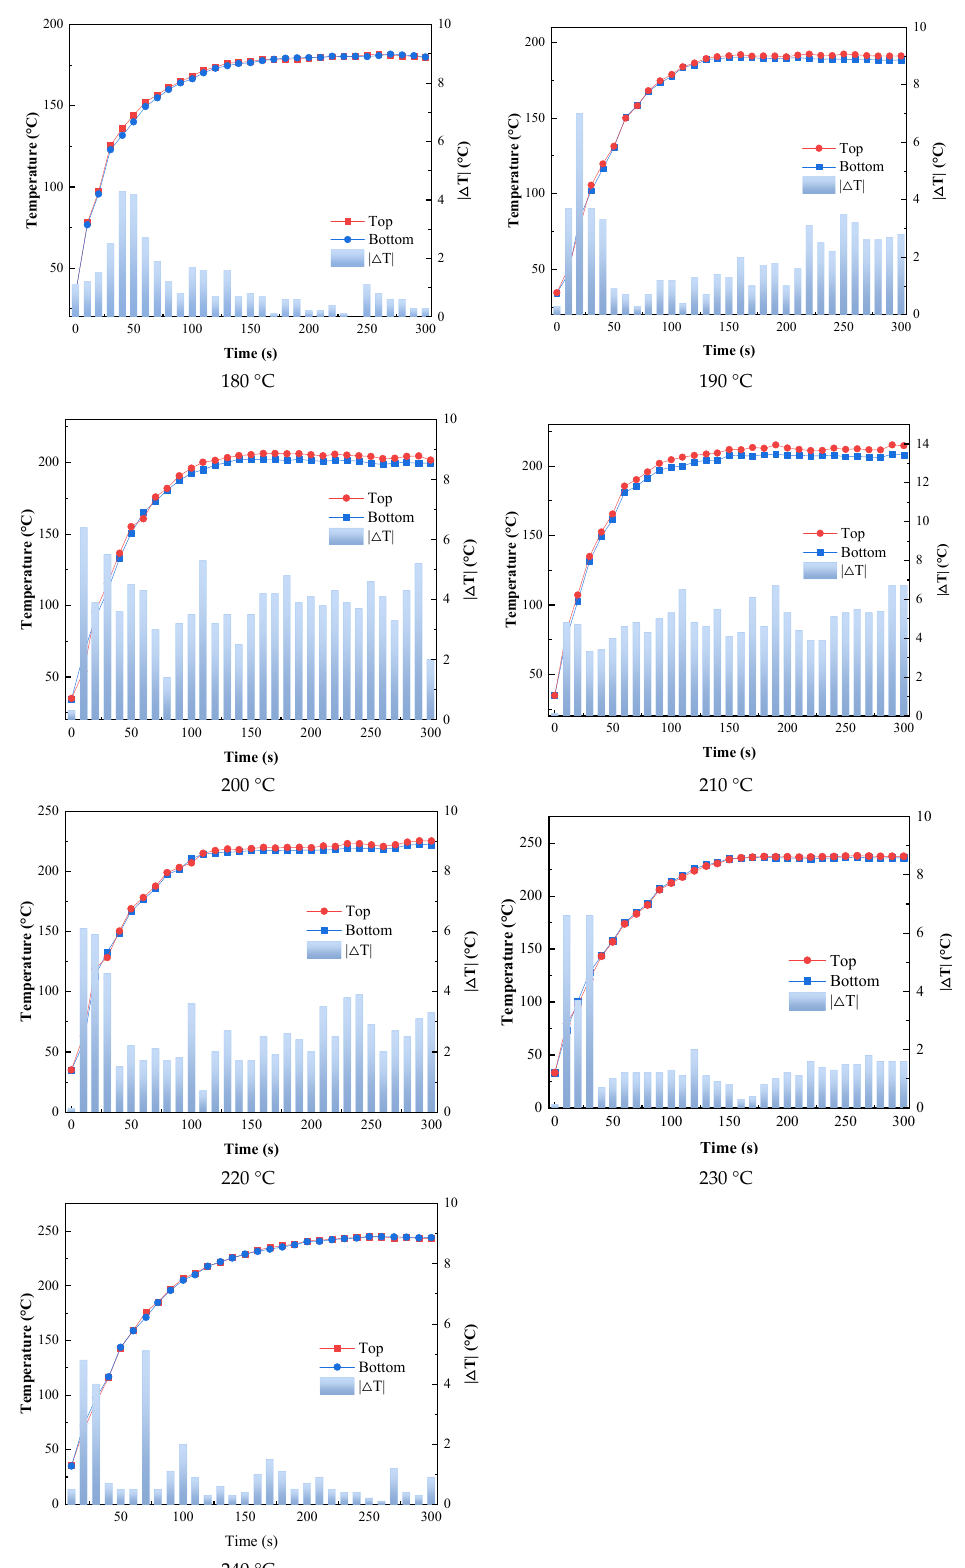
Figure 8. Variation in coating temperature and substrate bottom surface temperature with time.